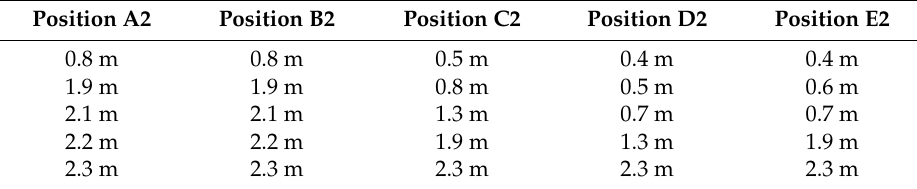
Figure 7. Test setup air temperature measurements: horizontal distances ( left ) and heights ( right) [28]. Table 2. Measurements heights (plane 2) of test set up air temperatures.